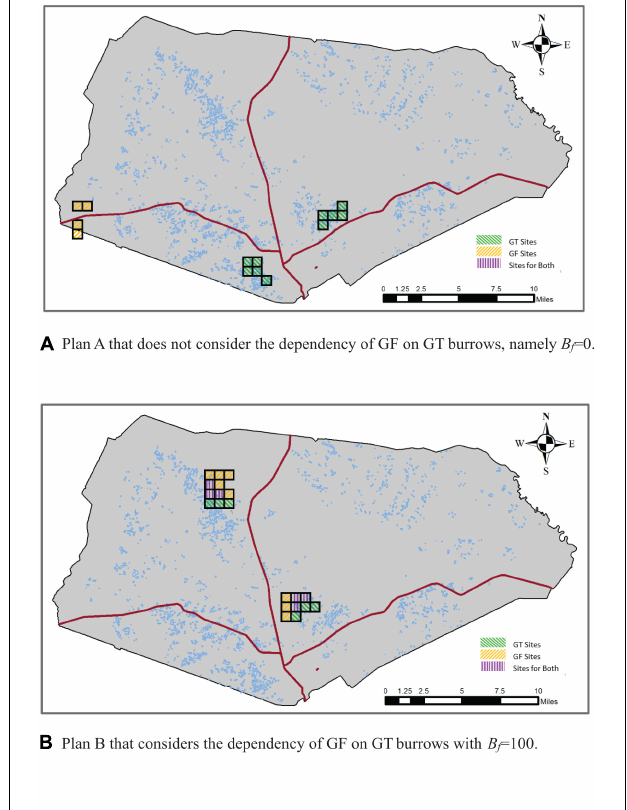
models. In the model, we allowed the selection of all of the 1,650 sites included in the partition (30 rows and 55